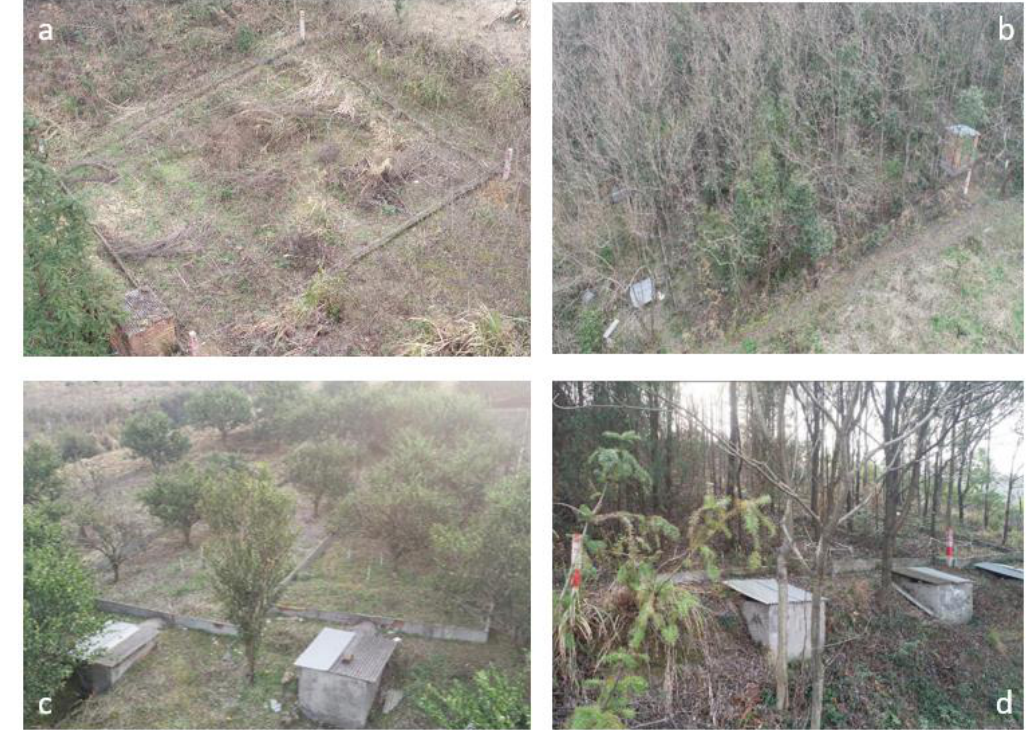
Figure 3. ( a ) Slope farmland (SF); ( b ) Eucommia ulmoides forest (EUF); ( c ) citrus reticulata forest (CRF); and ( d ) broad-leaf mixed forest (BMF).